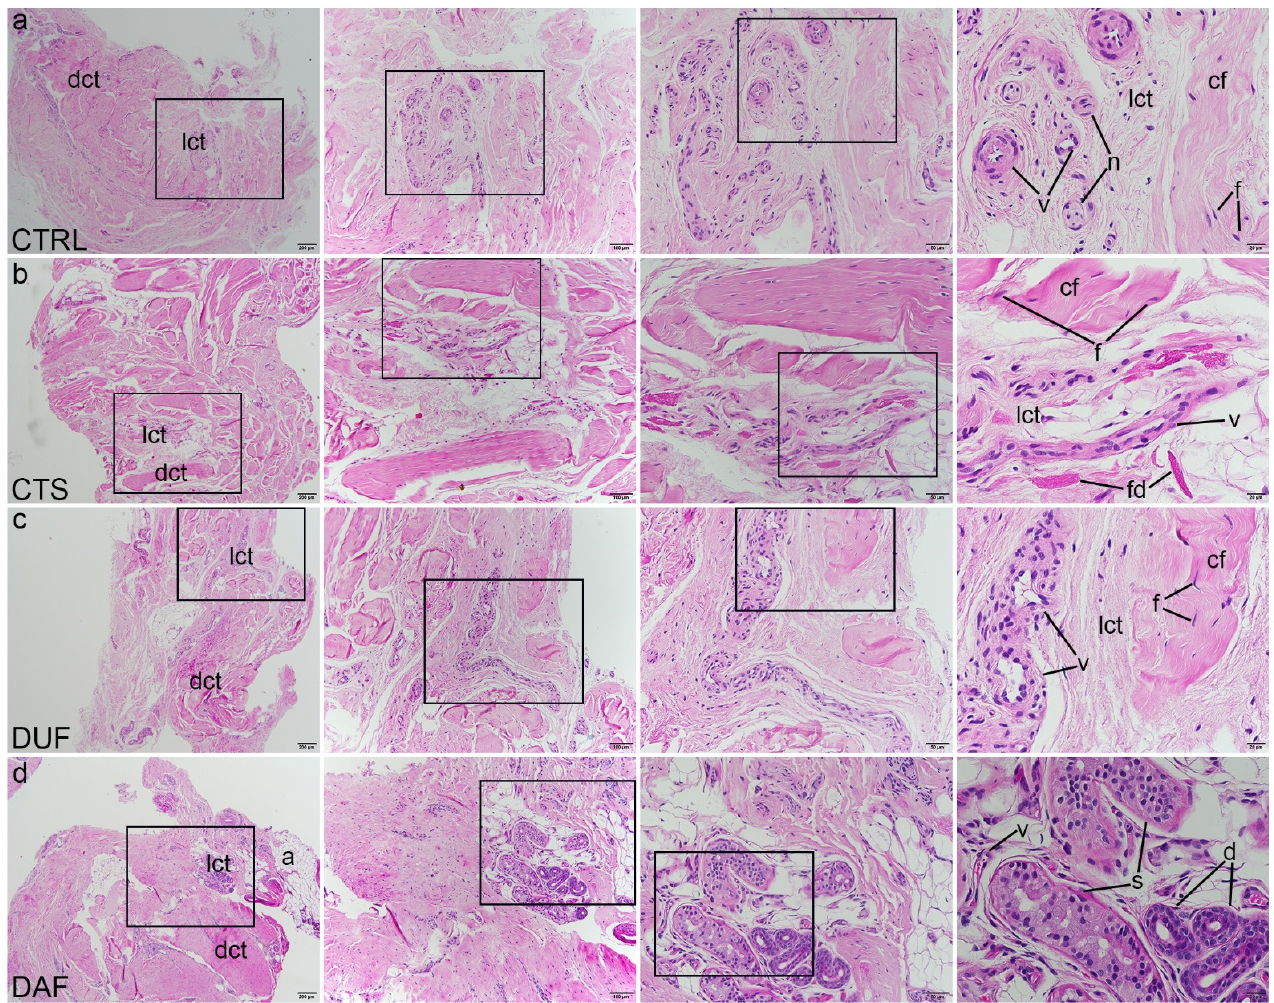
Figure 1. Haematoxylin and eosin staining of connective tissues of CTS and DD patients. Rectangles mark the area presented at a higher magnification in the following image. Control samples of healthy palmar fascia (CTRL) consist of dense connective tissue (dct) with bundles of collagen fibers (cf) with fibroblasts (f) and areas of loose connective tissue (lct) where blood vessels (v) and nerves (n) can be seen ( a ); in the flexor retinaculum of CTS patients, dense connective tissue (dct) has more densely packed collagen fibers (cf) and is separated by loose connective tissue (lct) in which blood vessels (v) and fibrinogen deposits (fd) can be observed ( b ); clinically unaffected palmar fascia of DD patients (DUF) displays areas of dense connective tissue (dct) with thick strands of collagen fibers (cf), separated by areas of loose connective tissue (lct) containing blood vessels (v) ( c ); samples of affected palmar fascia of DD patients (DAF) show large areas of dense connective tissue (dct) containing dense collagen fibers (cf) with many fibroblasts (f), separated by loose connective tissue (lct) containing blood vessels (v) and adipocytes (a); at places, ducts (d) and secretory portions (s) of sweat glands are seen ( d ); 1st column, 40× magnification, scale bar 200 µm ; 2nd column, 100× magnification, scale bar 100 µm; 3rd column, 200× magnification, scale bar 50 µm; 4th column, 400× magnification, scale bar 20 µm.